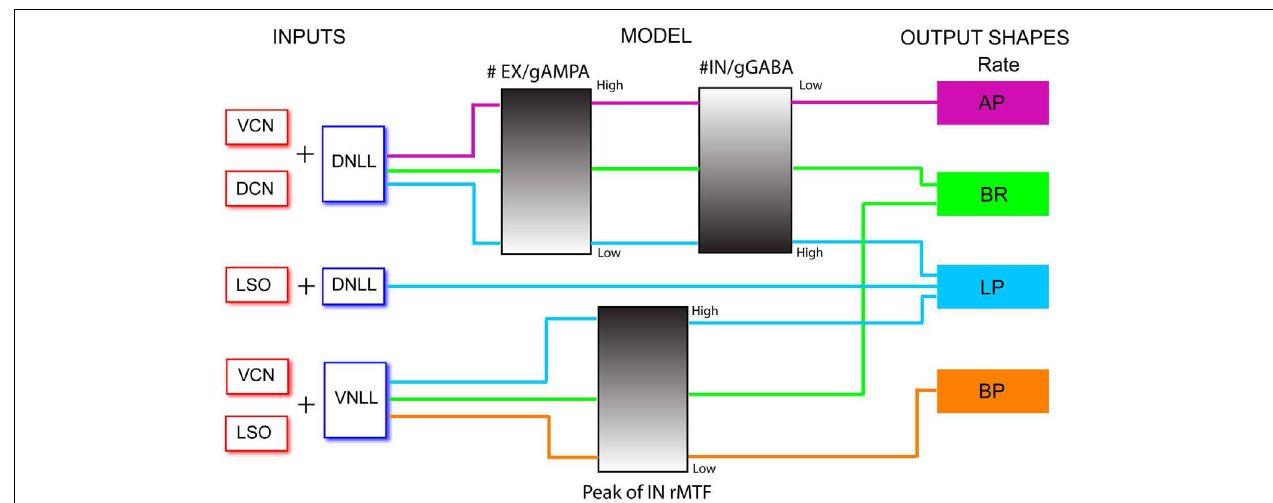
inputs, magnitude of synaptic conductances of AMPA or GABA A , duration of inhibitory post synaptic currents (IPSCs), or frequency of peak inhibitory input rMTF can shape output rate response and lines through gradients indicate magnitude of each parameter. Similar colored lines correspond to different rate output shapes ( right ) produced by different